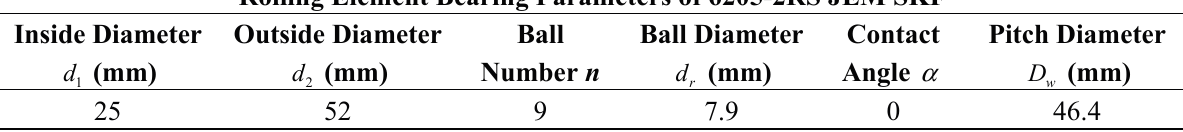
Table 2. Rolling element bearing parameters.